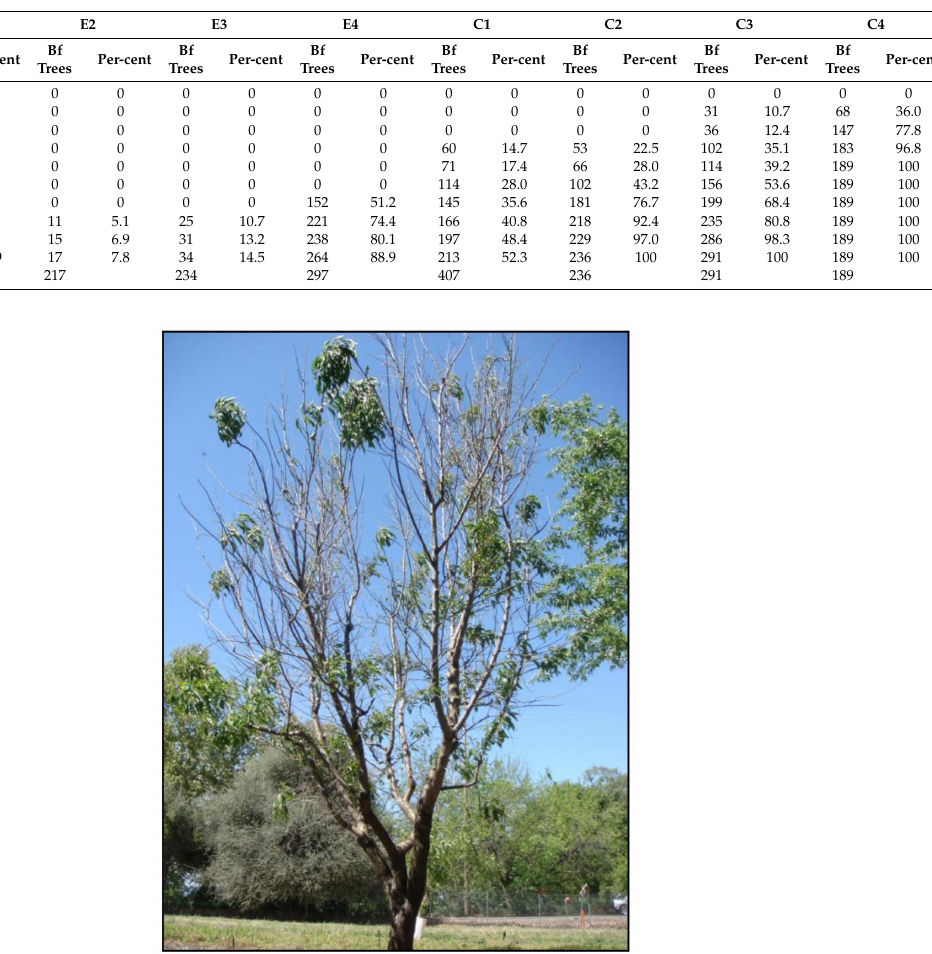
Table 3. Development of NBF over a 10 year of evaluation period for Carmel relic-tree basal epicormic